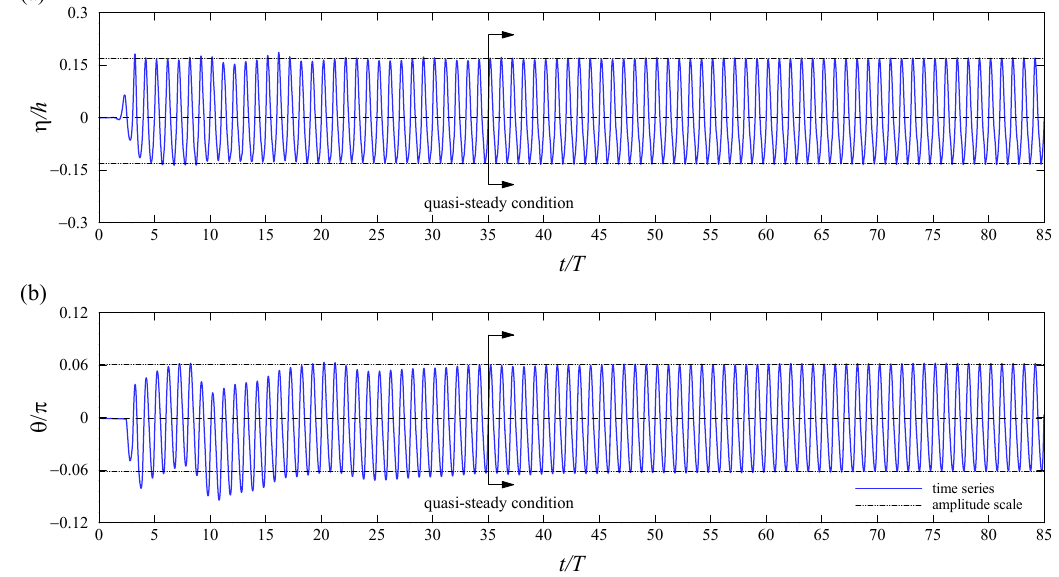
Figure 5. Full time series of normalized ( a ) free-surface elevation and ( b ) rotation angle of the flap. The dash-dotted line represents the amplitude scales. The vertical line at t / T = 35 indicates the beginning of the quasi-steady condition.